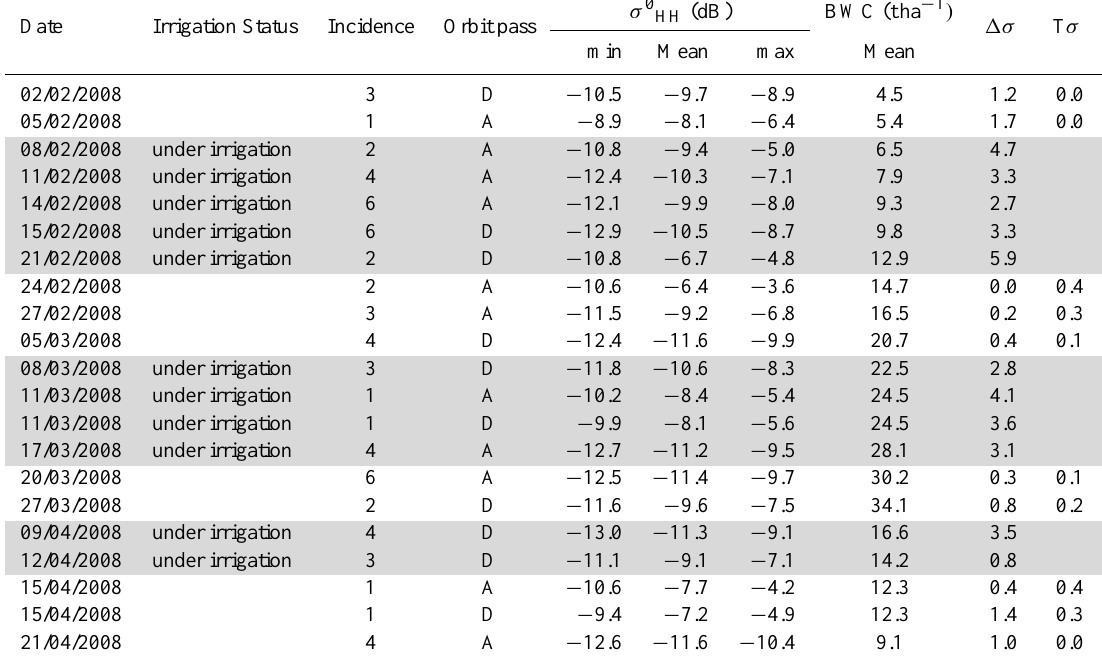
Table 1. Characteristics of Envisat/ASAR images and σ 0 HH statistics (minimal, mean, maximal values, amplitude 1σ and the trend T σ ) derived from the 17 segments of the largest wheat field, together with the average value of biomass water content BWC during the irrigation